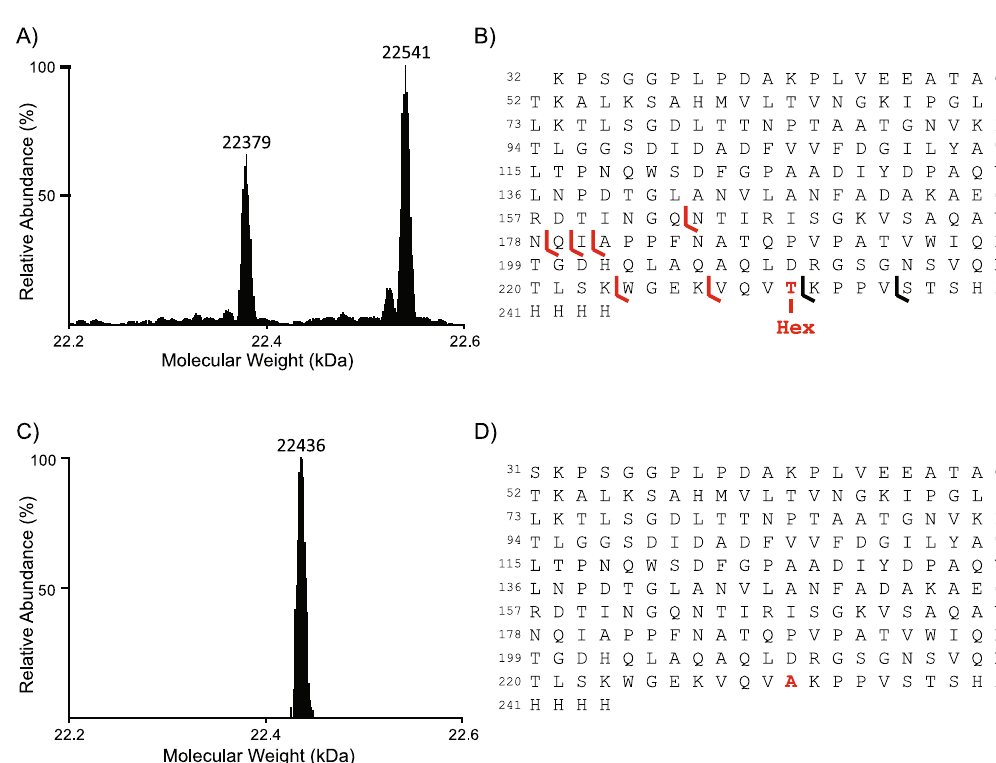
Figure 3. MS analyses of LprG and LprG T231A glycosylation. ( A ) Deconvoluted ESI-HRMS spectrum of the purified recombinant LprG-His expressed in M . tuberculosis . ( B ) Peptide sequence of the molecular species observed in A reporting the fragment ions detected in the top-down electron transfer dissociation spectrum of the fragmentation of the 22,541 Da molecular mass ion precursor allowing the localization of the unique hexose on the T231. ( C ) Deconvoluted ESI-HRMS spectrum of purified recombinant LprG-His T231A expressed in M . smegmatis demonstrating the absence of glycosylation of the mutated protein. ( D ) Peptide sequence of the molecular species observed in